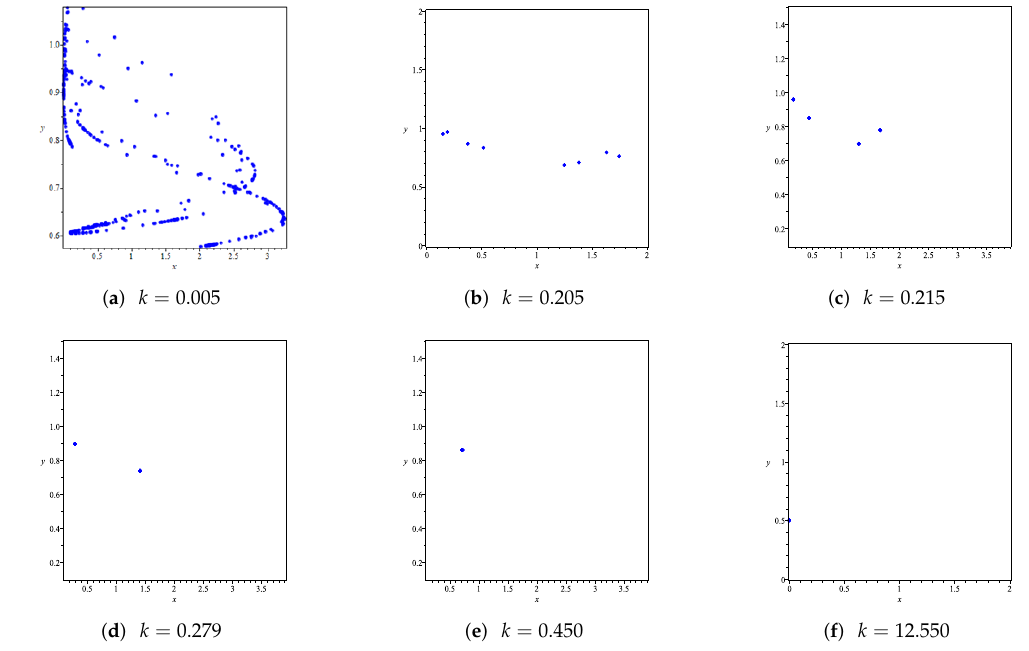
Figure 10. Phase portraits for various values of k corresponding to Figure 9. Example 4. The influence of fear effect on the positive equilibrium solution of